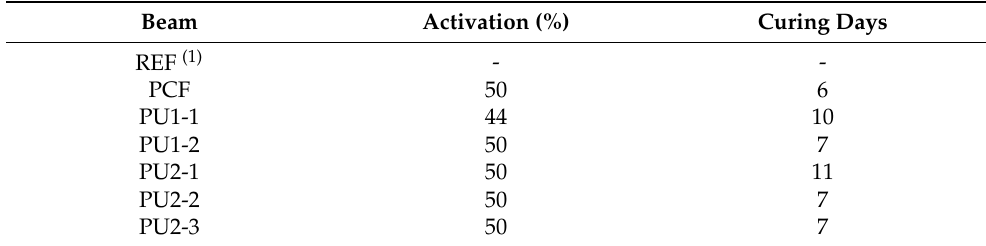
Table 4. Test program and activation